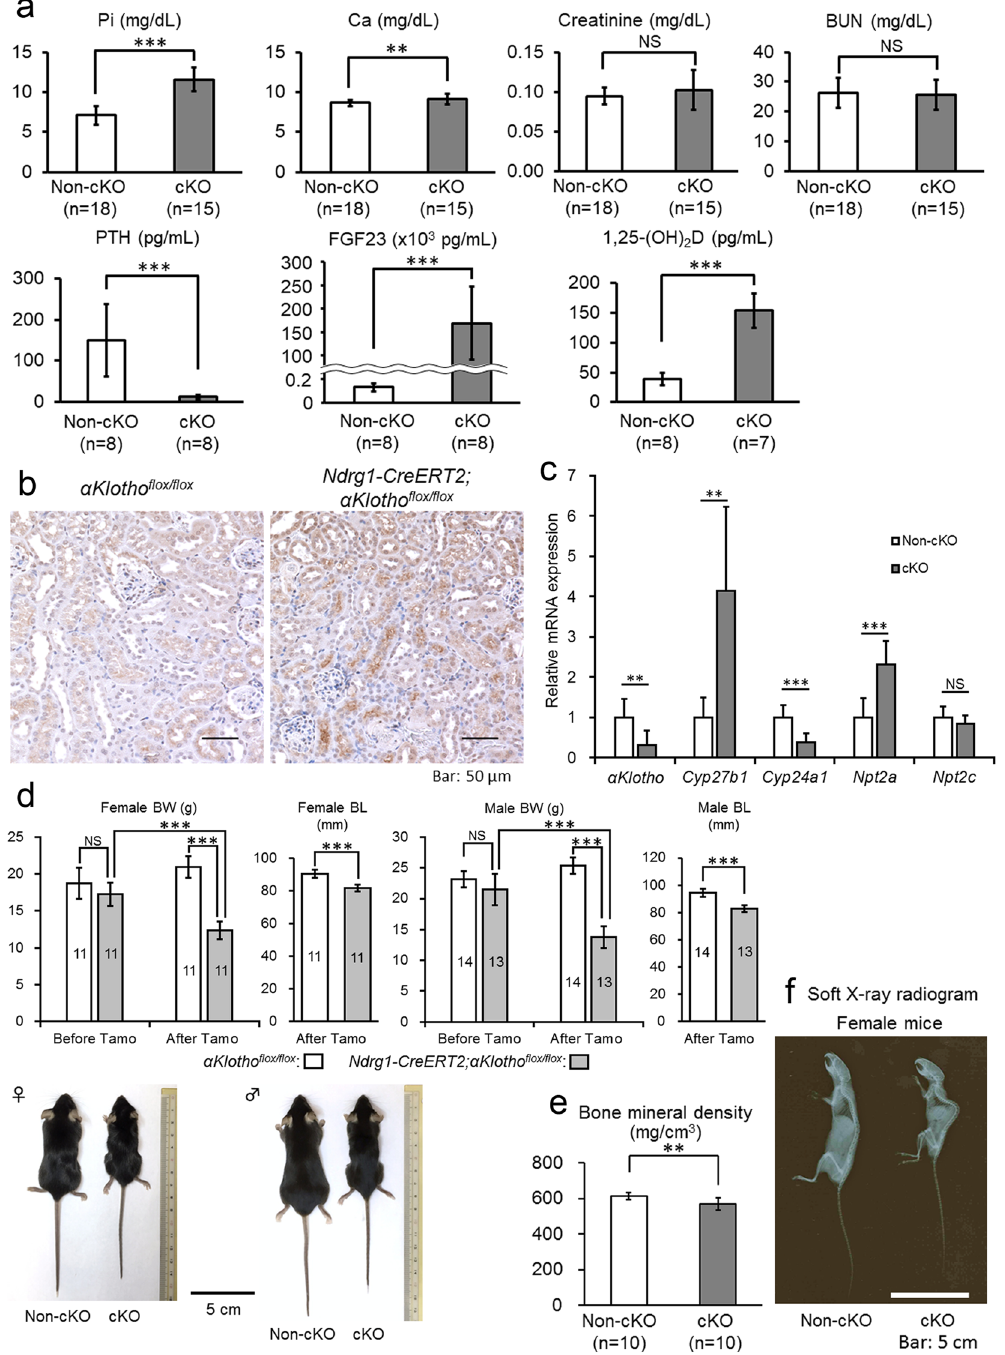
Figure 3. Proximal tubule-specific α Klotho cKO reproduces the phenotypes of systemic α Klotho KO. ( a ) Biochemical analysis of plasma inorganic phosphate (Pi), calcium (Ca), creatinine, blood urea nitrogen (BUN), parathyroid hormone (PTH), fibroblast growth factor 23 (FGF23), and 1,25-dihydroxyvitamin D (1,25(OH) 2 D) in α Klotho flox / flox (non-cKO) and Ndrg1-CreERT2; α Klotho flox / flox (cKO) mice at 9 weeks of age at 3 weeks after the induction of Cre by tamoxifen treatment. These parameters were measured as described in the Methods section. Values are expressed as mean ± s.d. Number of samples (n) is described in the figure. ( b ) Expression of NPT2A in the renal cortex. Kidney sections were immunostained for NPT2A with the standard DAB method. ( c ) Reverse transcription quantitative polymerase chain reaction (RT-qPCR) of RNA extracted from the kidney. RT-qPCR was performed as described in the Methods section. Primers used for these studies are listed in Supplementary Table S4. Values are expressed as mean ± s.d. of 7 samples for non-cKO mice and 8 samples for cKO mice. ( d ) Mouse body size. Body weight (BW) was measured at 6 weeks of age before Cre induction and at 9 weeks of age at 3 weeks after Cre induction, whereas body length (BL) was measured only at 3 weeks after Cre induction. Data show a body size reduction in α Klotho cKO mice as compared with non-cKO control